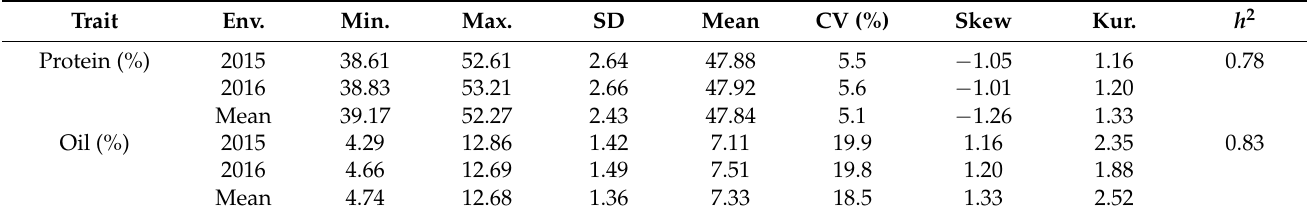
Table 1. Descriptive statistics for the protein and oil content in 2015 and 2016. Trait Env. Min.